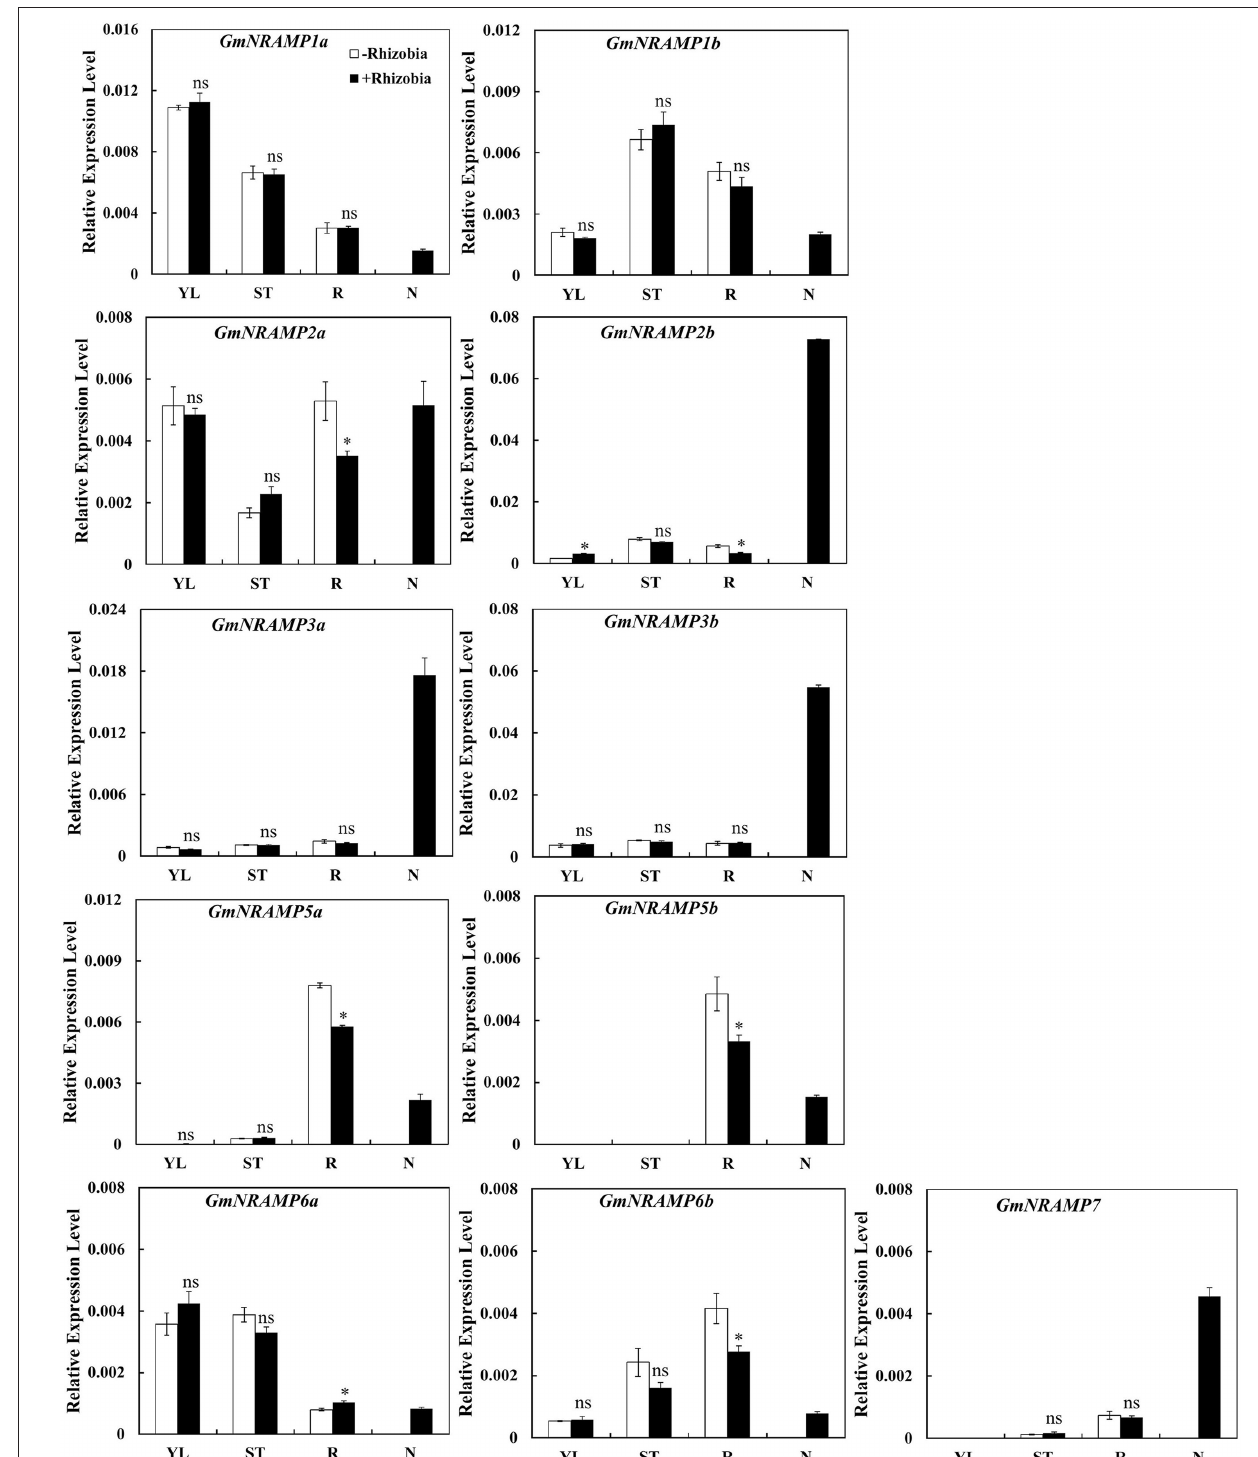
FIGURE 9 | Expression of GmNRAMPs in response to rhizobia inoculation. Seven-day-old soybean seedlings were inoculated with rhizobial strain Bradyrhizobium sp. BXYD3 and then transplanted into low nitrogen (500 µ M N added) nutrient solution. Various tissues including young leaves (YL), stems (ST), roots (R), and nodules (N) were separately collected 30 days after inoculation. Relative expression levels were obtained by real-time PCR normalized against the reference gene TefS1 . Each bar is the mean of four biological replicates with standard error. “*” indicates significant differences between soybean without and with rhizobia inoculation in young leaves, stems, and roots in one-way analysis of variance, * P <